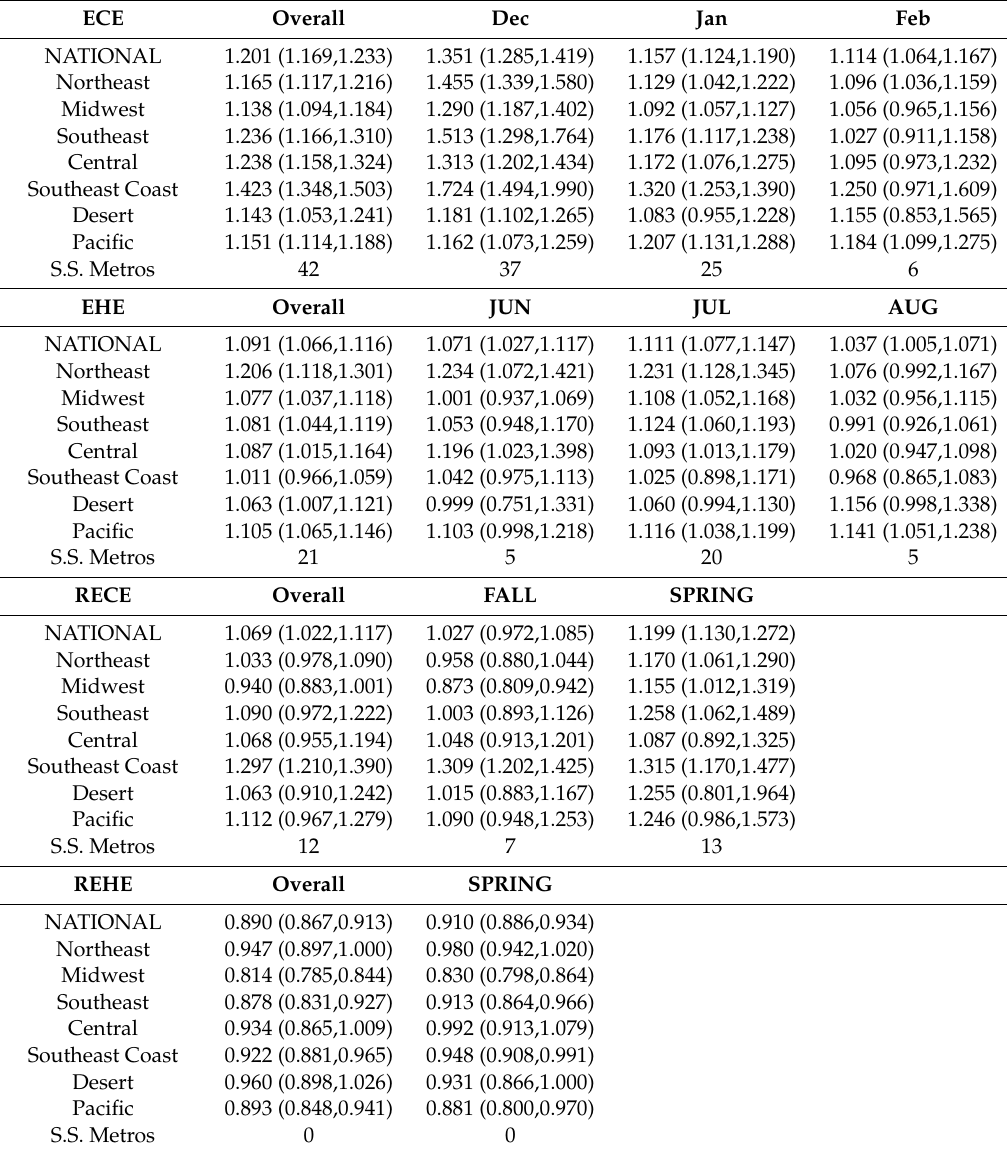
Table 3. Cumulative 20-day relative risks for ETEs by region, and number of statistically significant metropolitan